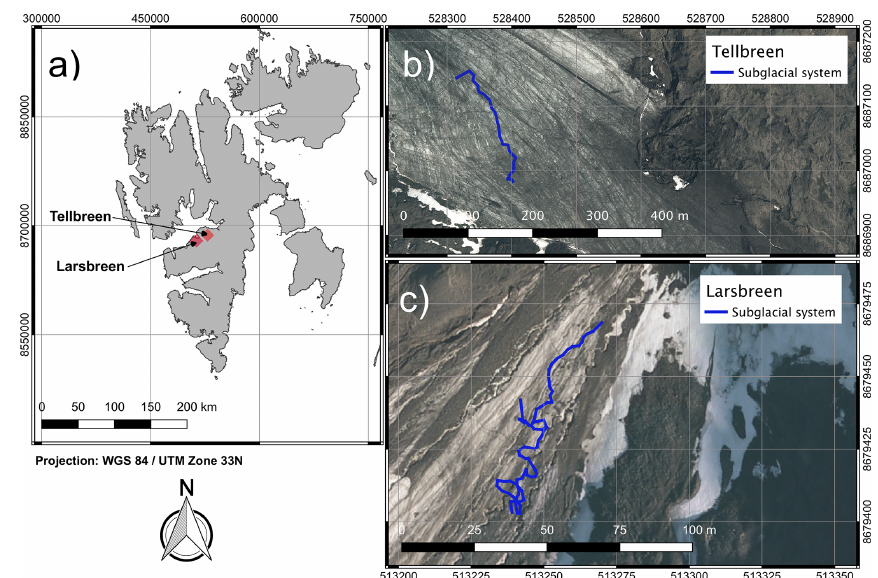
Figure 1. (a) Overview map of Svalbard, showing the locations of Larsbreen and Tellbreen on the Svalbard archipelago. (b) Frontal part of Tellbreen with the center line of the subglacial system indicated (background aerial image © Norwegian Polar Institute). (c) Frontal part of Larsbreen with the center line of the subglacial system (background aerial image © Norwegian Polar